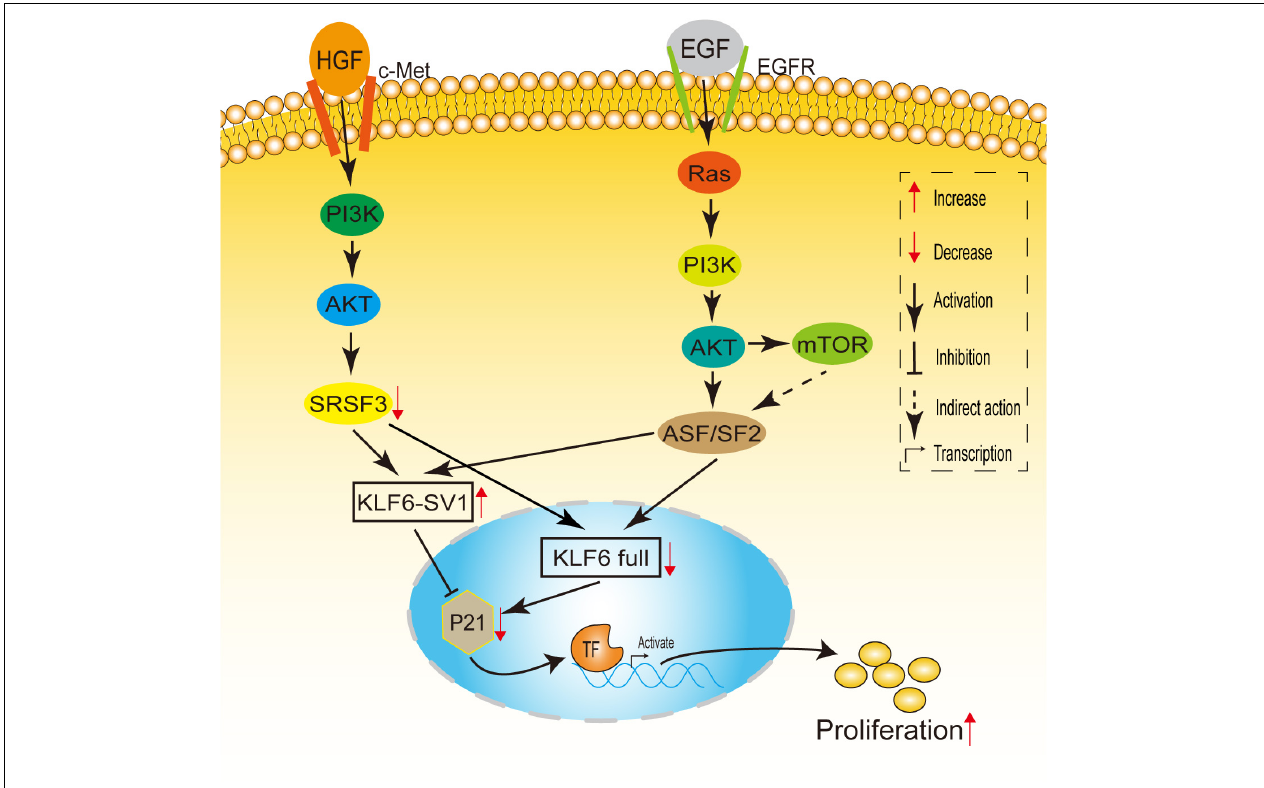
FIGURE 3 | A model linking Ras and HGF signaling to KLF6 alternative splicing. HGF induces c-Met, PI3K/Akt, which downregulates SRSF1 levels. Decreased SRSF1 enhances KLF6 alternative splicing, altering the SV1/KLF6 full ratio, leading to increased cell proliferation. EGF receptor potentially can activate Ras signaling. When Ras is activated, signals are transduced through PI3-K/Akt to ASF/SF2, up-regulating KLF6 SV1 expression and leading to cellular proliferation. mTOR also may play a role in ASF/SF2-dependent or ASF/SF2-independent KLF6 alternative